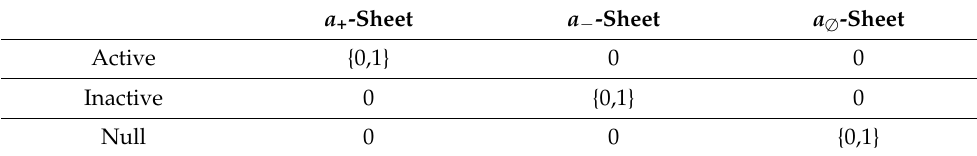
Table 1. Summary of characteristic function values for the three subrelations.